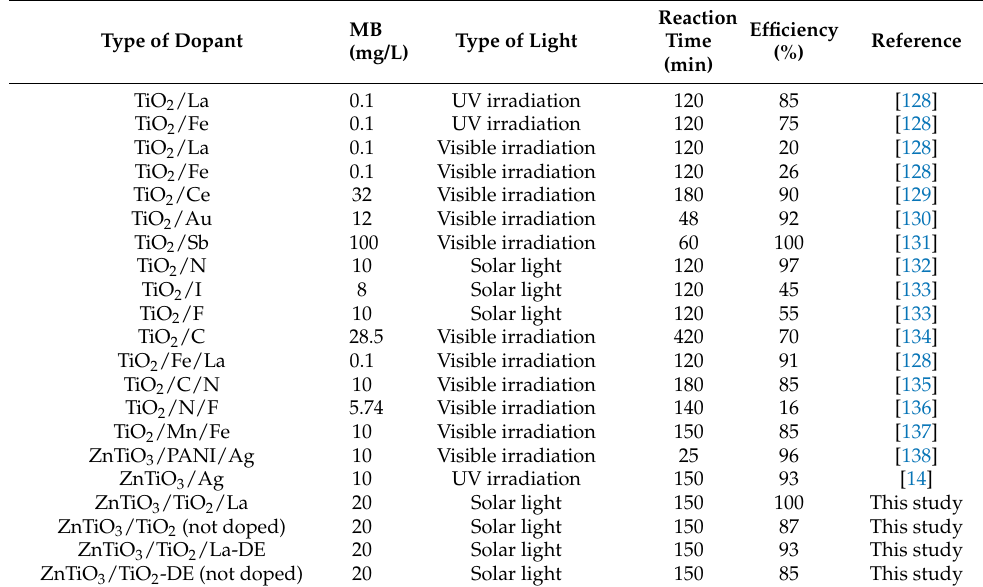
Table 6. Different operating conditions and efficiency for the photocatalytic oxidation of MB by different doping